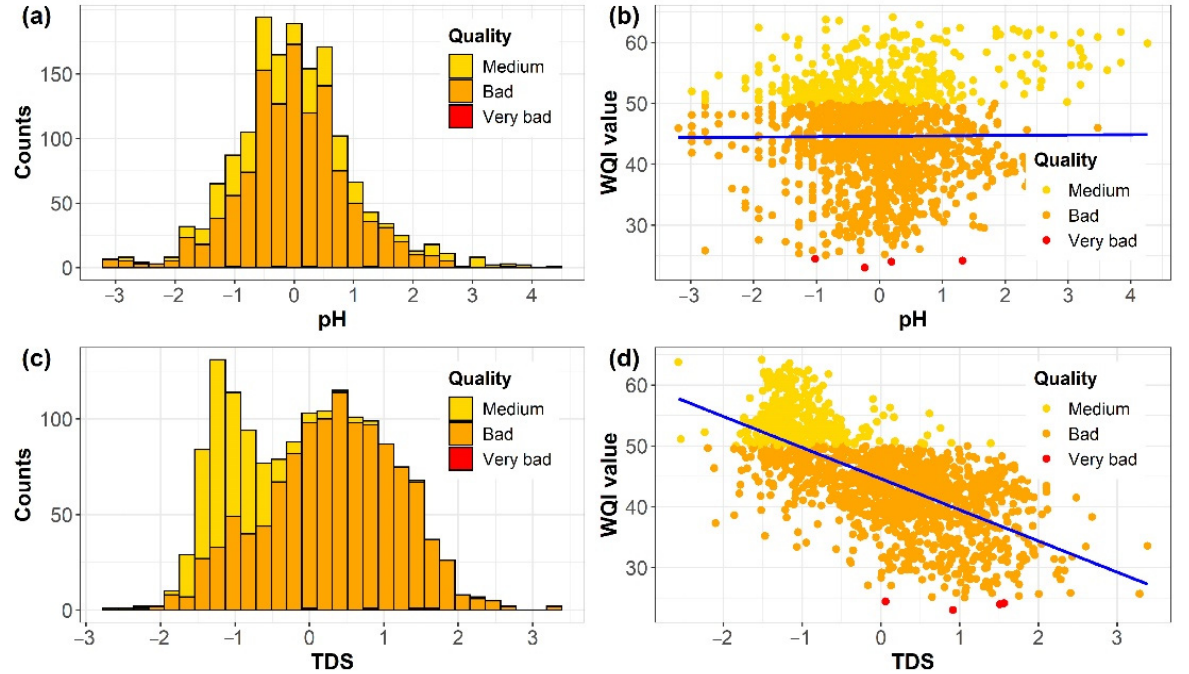
Figure 6. Distributions ( a , c ) and simple linear regressions ( b , d ) for pH and TDS. 4.3.2. Multiple Linear Regression